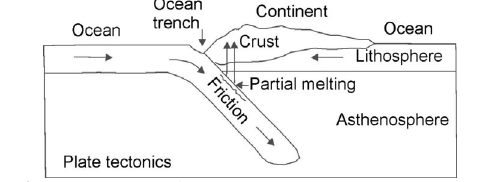
Fig 1. Example of geophysical processes causing vertical movements [2]